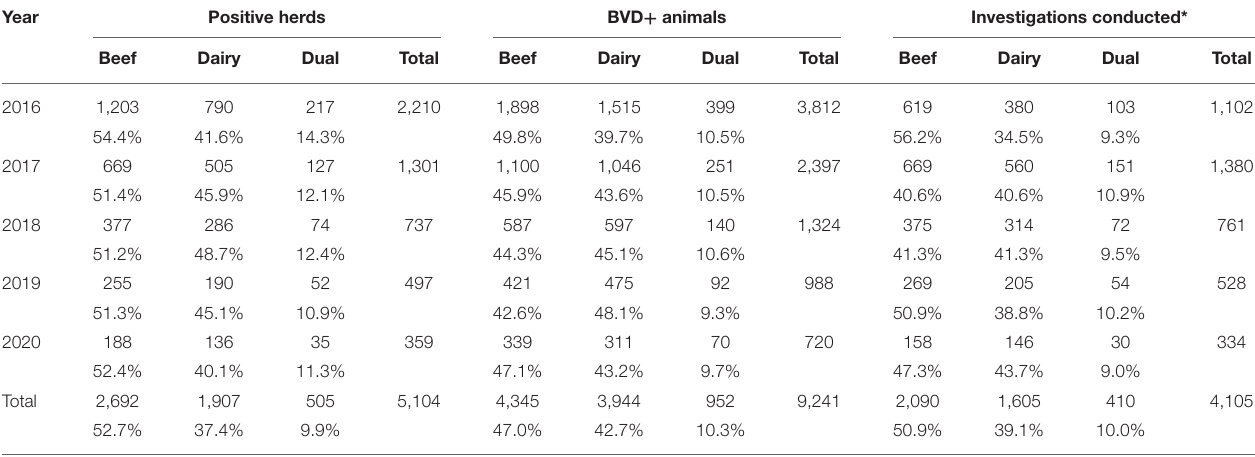
TABLE 2 | Number (%) of positive herds overall and by herd type, number of BVD + animals in these herds and the number (%) of these herds in which a BVD investigation was conducted each year and in total. Year Positive herds BVD +